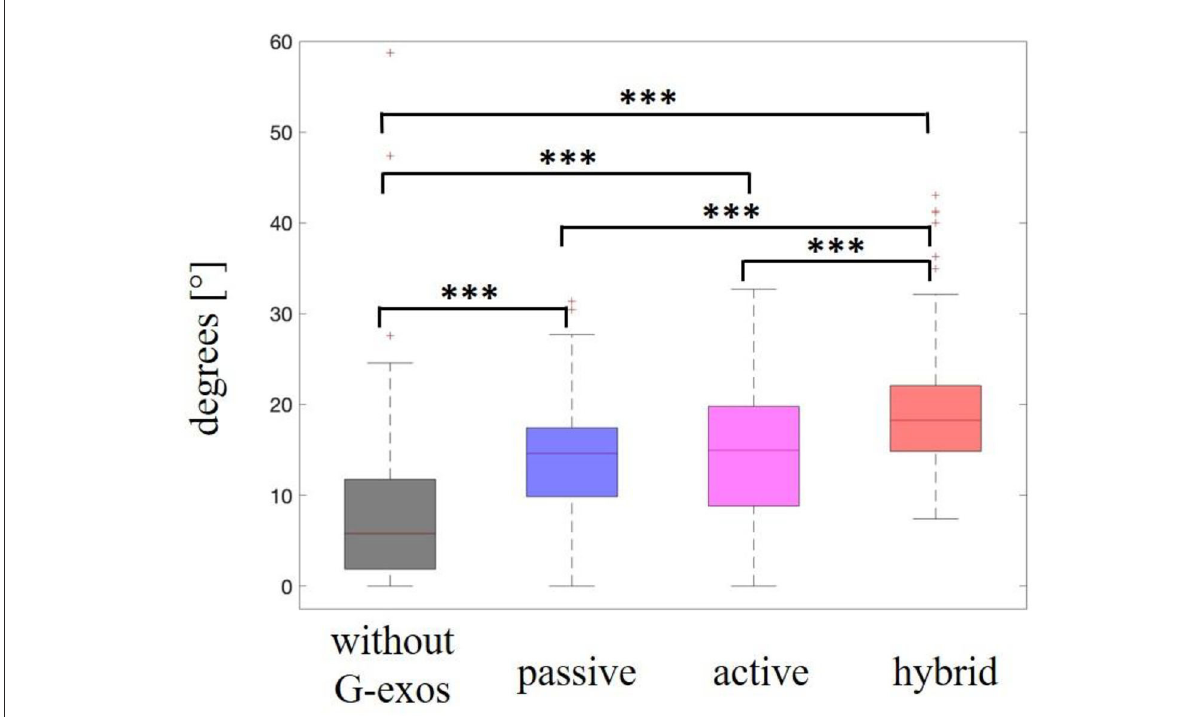
FIGURE10 Range of motion of ankle dorsiflexion in volunteers with foot drop. Statistically significant differences are shown with the stars (*** p -value < 0.001). Here we see a comparison of range of motion of ankle dorsiflexion without the use of the G-Exos, with the passive system, with the active system, and with the hybrid system (active and passive), and only the comparison of the passive and active systems was not significantly different. Median represented in the second